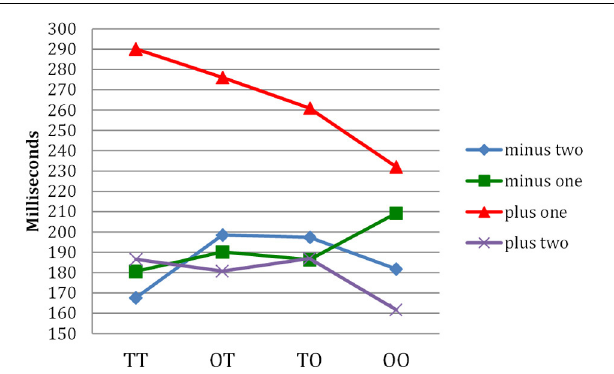
FIGURE 3 | Letter typing times in milliseconds for four types of compounds investigated by Libben and Weber (2014). The morpheme boundary is considered to be position zero . Position minus two is thus two letters before the boundary, position minus one is the letter before, and position plus one is the letter immediately following the morphemic boundary. Thus, for the compound sailboat, positions minus two to plus two would comprise the letters “i,” “l,” “b,” and “o.” The time taken to type the letter at position plus one (e.g., the “b” in sailboat ) is interpreted as the time taken to pause at the morpheme